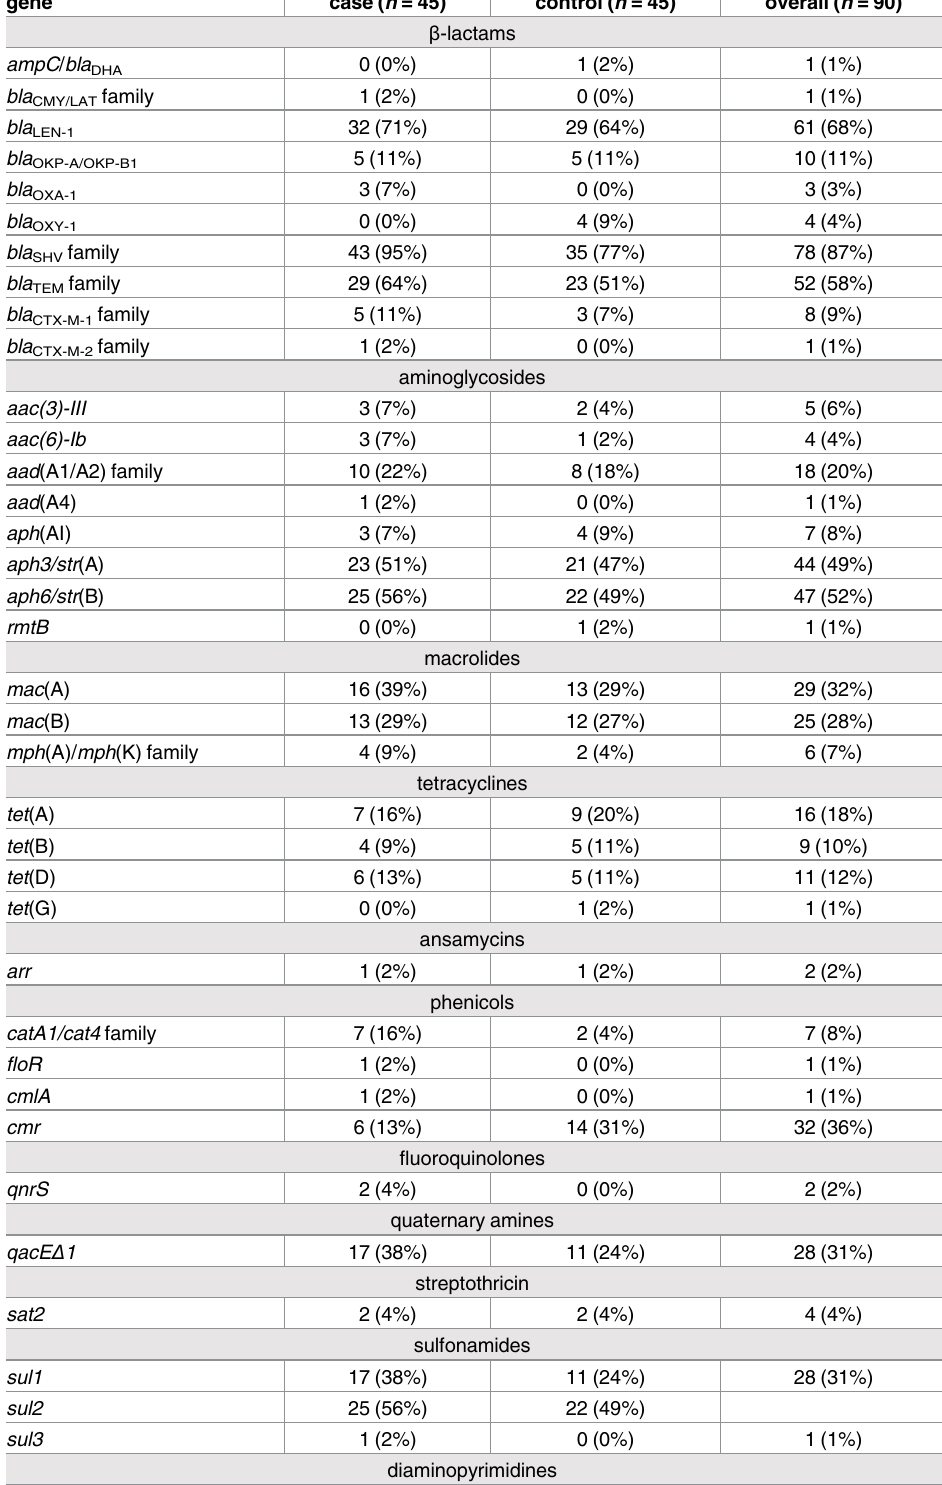
Table 3. Summary of AMR genes in the tested